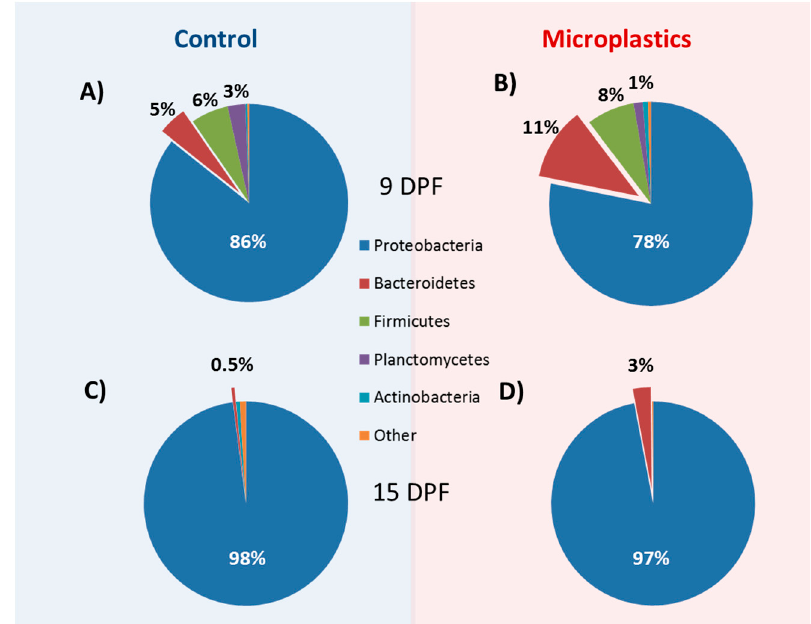
Figure 3. Relative phylum composition of control and MP-exposed zebrafish larvae. Zebrafish larvae were exposed to control conditions ( A , C ) and microplastics ( B , D ) for 4 days ( A , B ) and 10 days ( C , D ), respectively. Percentages represent the relative abundance of the most represented phyla.